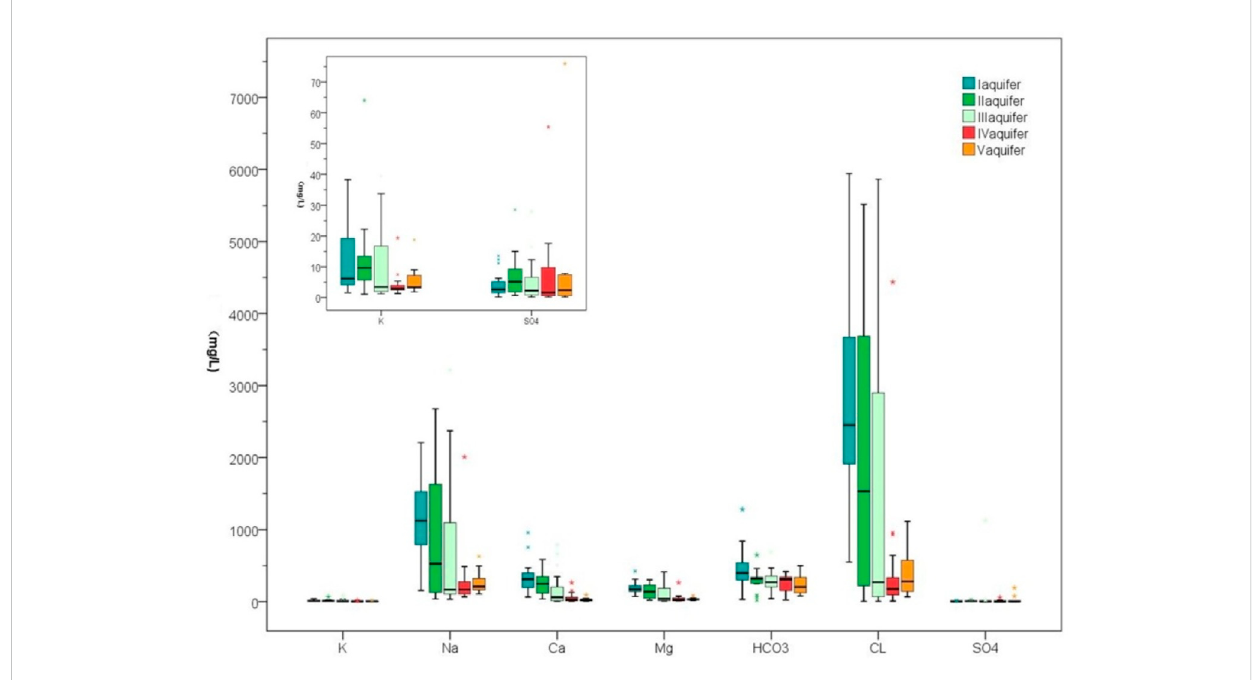
FIGURE 4 Ranges of major-ion concentrations in con fi ned groundwater